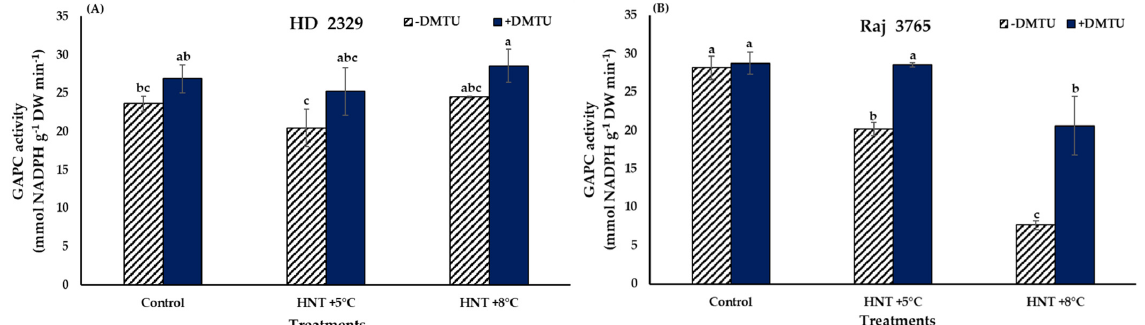
Figure 9. Effect of HNT on GAPC activity in pistil of wheat genotypes ( A ) HD 2329 (sensitive) and ( B ) Raj 3765 (tolerant) under control, HNT (+5 °C) and HNT (+8 °C) conditions in absence and pres- ence of ROS scavenger (DMTU). Bars represent mean ± SE. Bars with common letter are not signif- icantly different between temperature treatments in a genotype at p < 0.05.